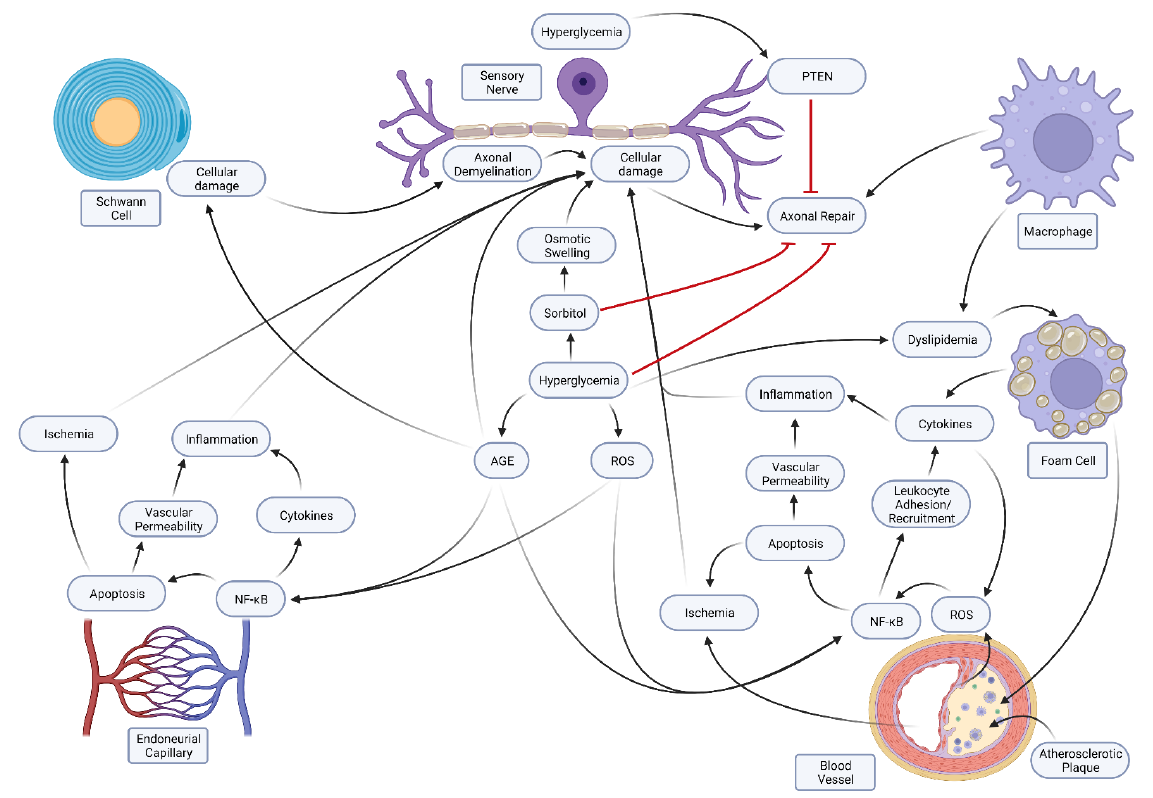
Figure 1. Pathways Involved in diabetic neuropathy: hyperglycemia causes diabetic neuropathy through several pathways. Elevated blood glucose leads to an increased conversion of glucose to sorbitol. Sorbitol can cause osmotic swelling, causing compression neuropathy, and can inhibit axonal repair mechanisms. Hyperglycemia can also cause direct damage to nerve cells through the stimulation of the PTEN (phosphatase and tensin homolog) pathway. Hyperglycemia causes Schwann cell toxicity, thereby producing advanced glycation end products (AGEs) and leading to axonal demyelination. Macrophages are important for nerve repair and regeneration, but can be inhibited by hyperglycemia. Hyperglycemia also leads to dyslipidemia and the formation of foam cells from macrophages. These foam cells contribute to the formation of atherosclerotic plaques, leading to vascular and endoneurial microvascular damage to produce reactive oxygen species (ROS). ROS use the NF- κB pathways to cause leukocyte recruitment and apoptosis, leading to inflammation, ischemia, and cellular nerve damage [16].